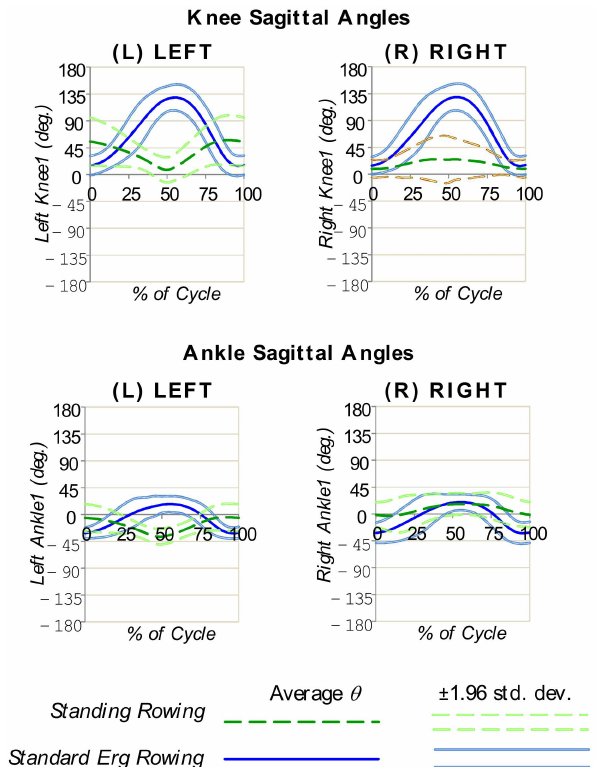
Figure 9. The averaged angular measurements for the knee and ankle (sagittal) from the laboratory study, reported as mean ± 1.96 s.d., which compares standing rowing (green) with standard ergometer sliding-seat rowing